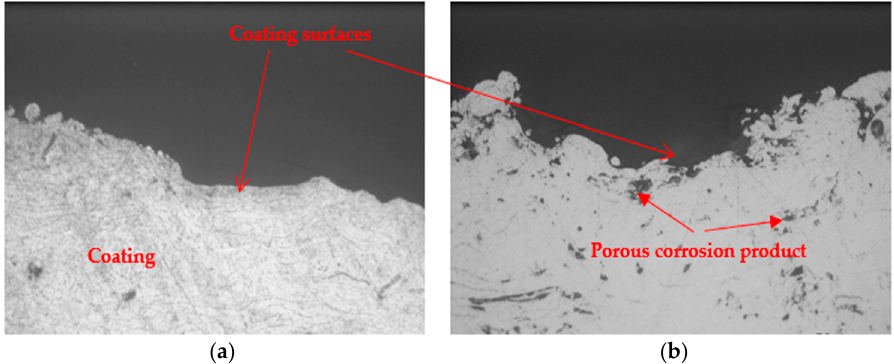
Figure 13. SEM micrographs of the Wire arc deposited Al-Zn coating ( a ) before and ( b ) after corrosion.